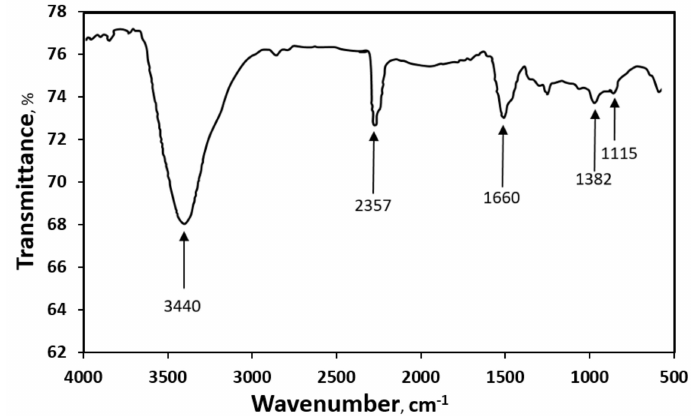
Figure 2. FTIR spectrum of